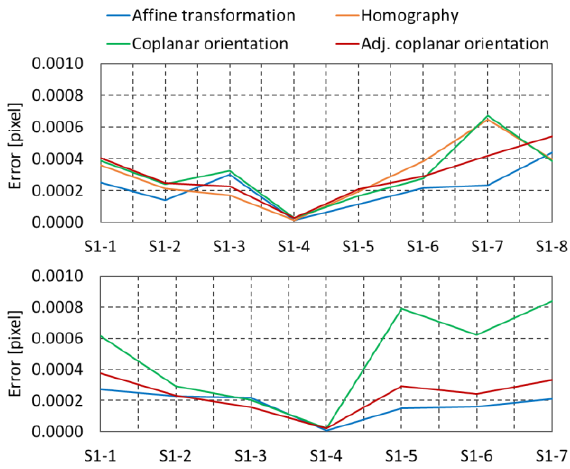
Figure 4. Reprojection errors for each transformation model (Top: Strip1 result, Bottom: Strip2